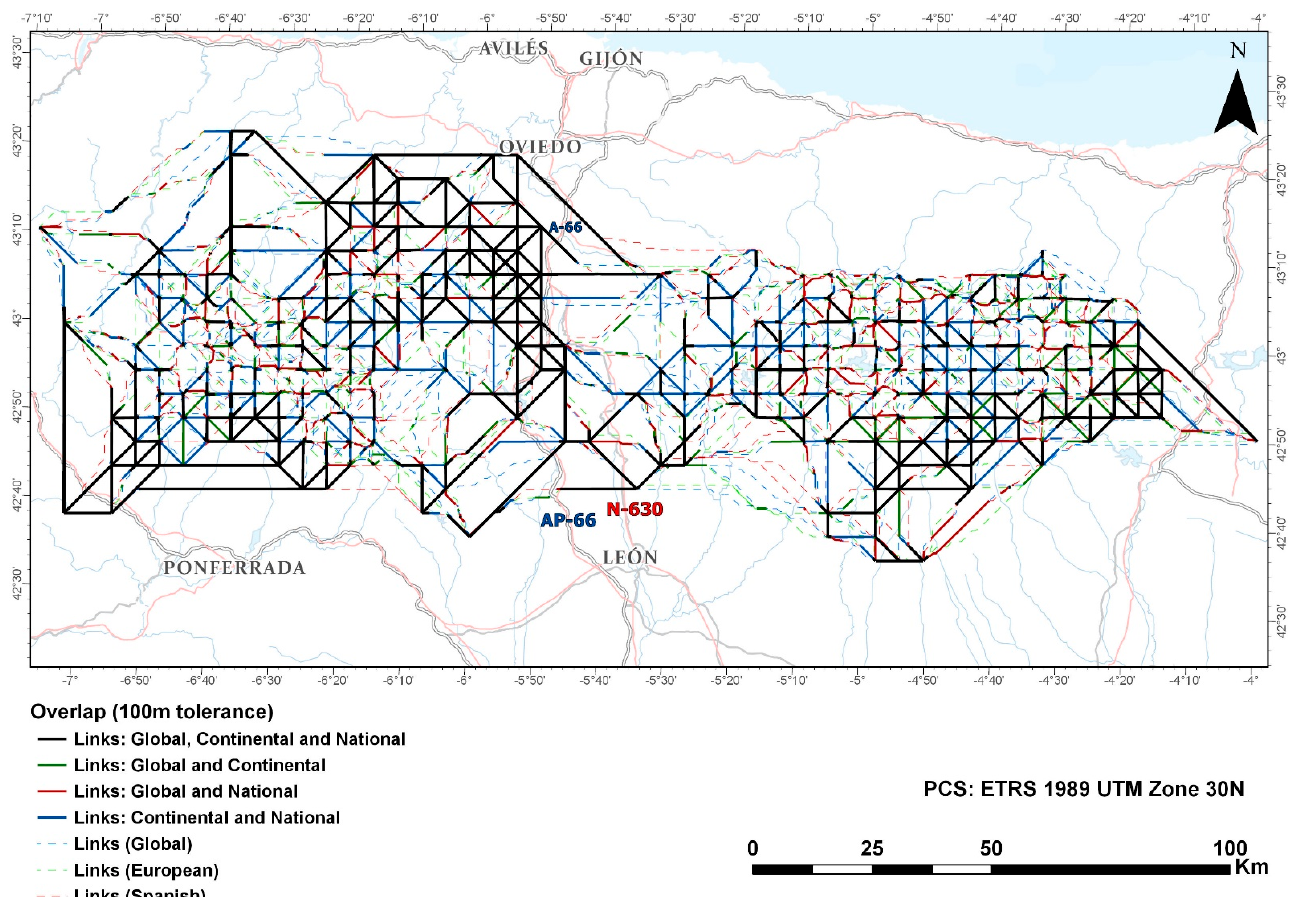
Figure 3. Links based on the least-cost modeling methodology for the three resistance surfaces (global, continental and national) and overlaps of their trajectories using 100 m of tolerance (see Figure A4 in Appendix B for the links of the genetic model).